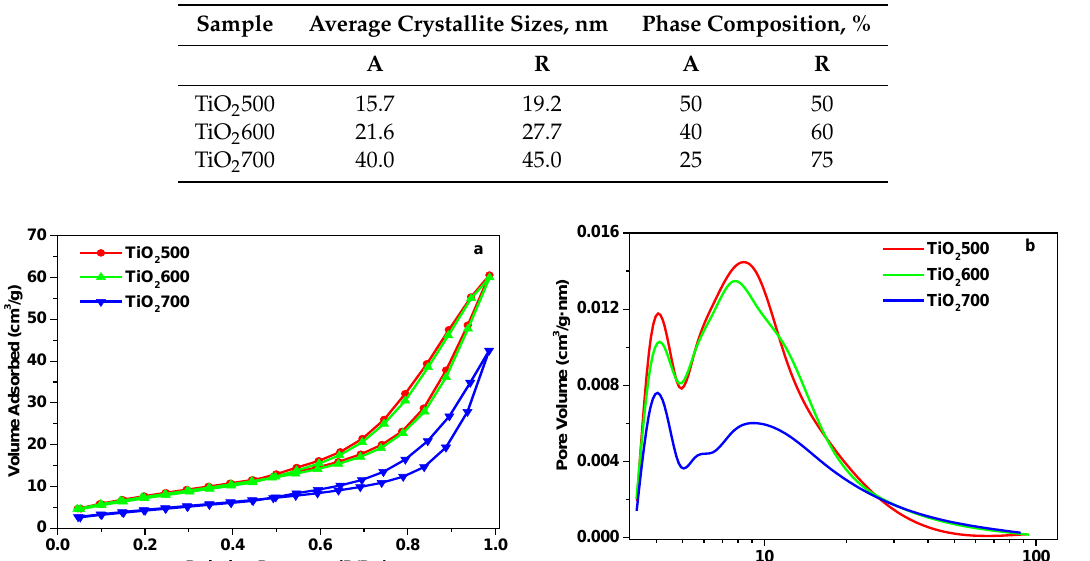
Table 1. Phase composition and average crystallite size of the fibrous TiO 2 .